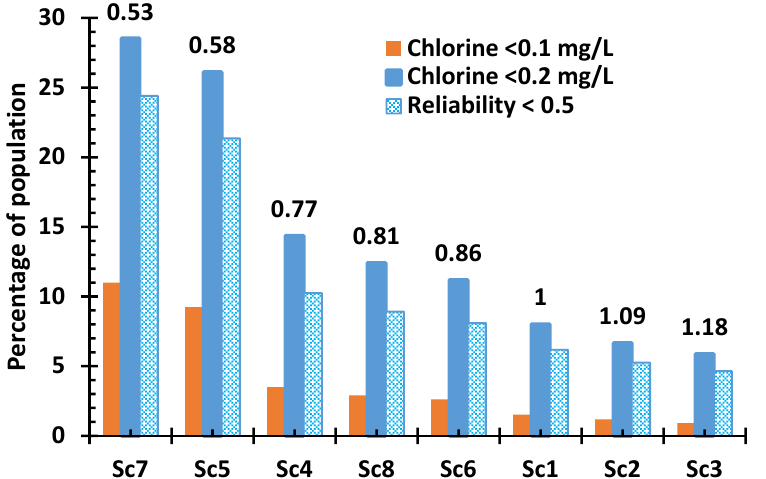
Figure 9. Fraction of total population supplied with water having a daily minimum chlorine level of <0.2 and <0.1 mg/L and a chlorine reliability of <0.5, using 0.2 mg/L as the threshold. The global multiplicative factor (F G ) for each scenario is indicated above each column.